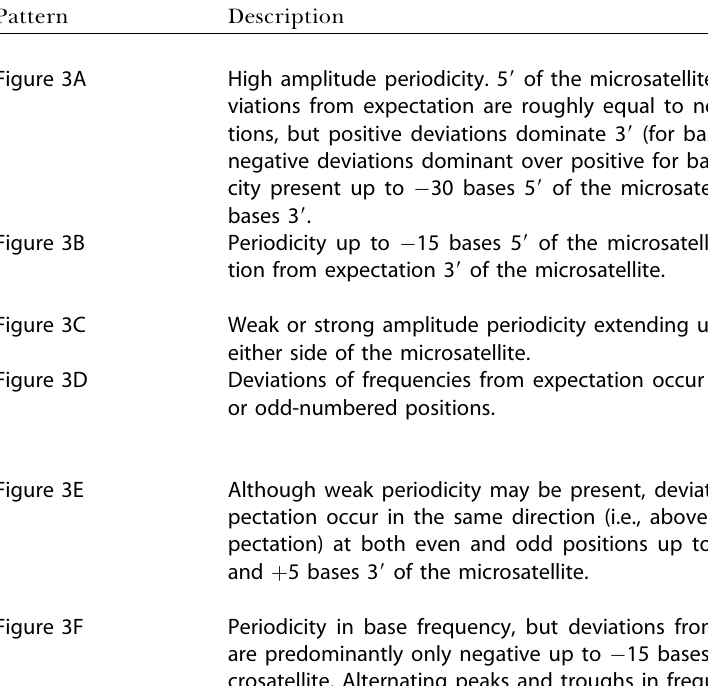
Figure 3E Although weak periodicity may be present, deviations from ex- pectation occur in the same direction (i.e., above or below ex- pectation) at both even and odd positions up to (cid:1) 5 bases 5 9 and þ 5 bases 3 9 of the microsatellite. Figure 3F Periodicity in base frequency, but deviations from expectation are predominantly only negative up to (cid:1) 15 bases 5 9 of the mi- crosatellite. Alternating peaks and troughs in frequency extend- ing over (cid:1) 40 bases away from the microsatellite.